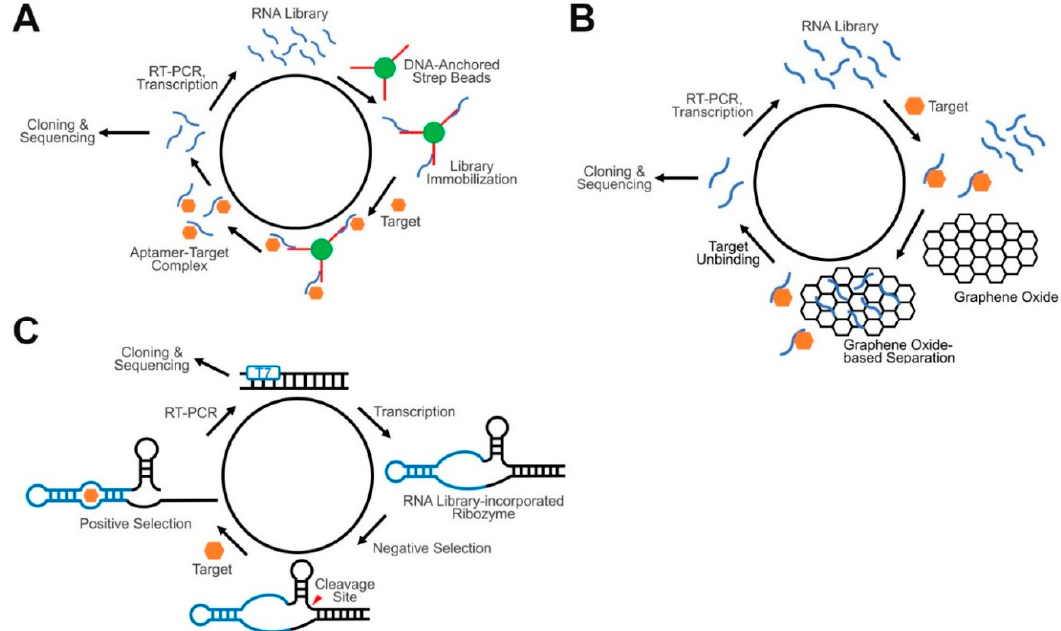
Figure 3. Schematics of advanced SELEX approaches for GERMS. ( A ) In a Capture-SELEX, an RNA library is immobilized on the surface of beads via the attached short capture DNA. RNA aptamers that can bind with the target and undergo conformational changes will be eluted and further amplified. ( B ) In a graphene oxide SELEX, target unbound RNA strands adsorb onto the surface of graphene oxide and separate from target-binding aptamers. ( C ) In a ribozyme-based SELEX, target-binding aptamers induce the catalytic self-cleavage of the ribozyme. Based on the band shift in gel electrophoresis, aptamer-containing constructs can be isolated from the RNA pool.